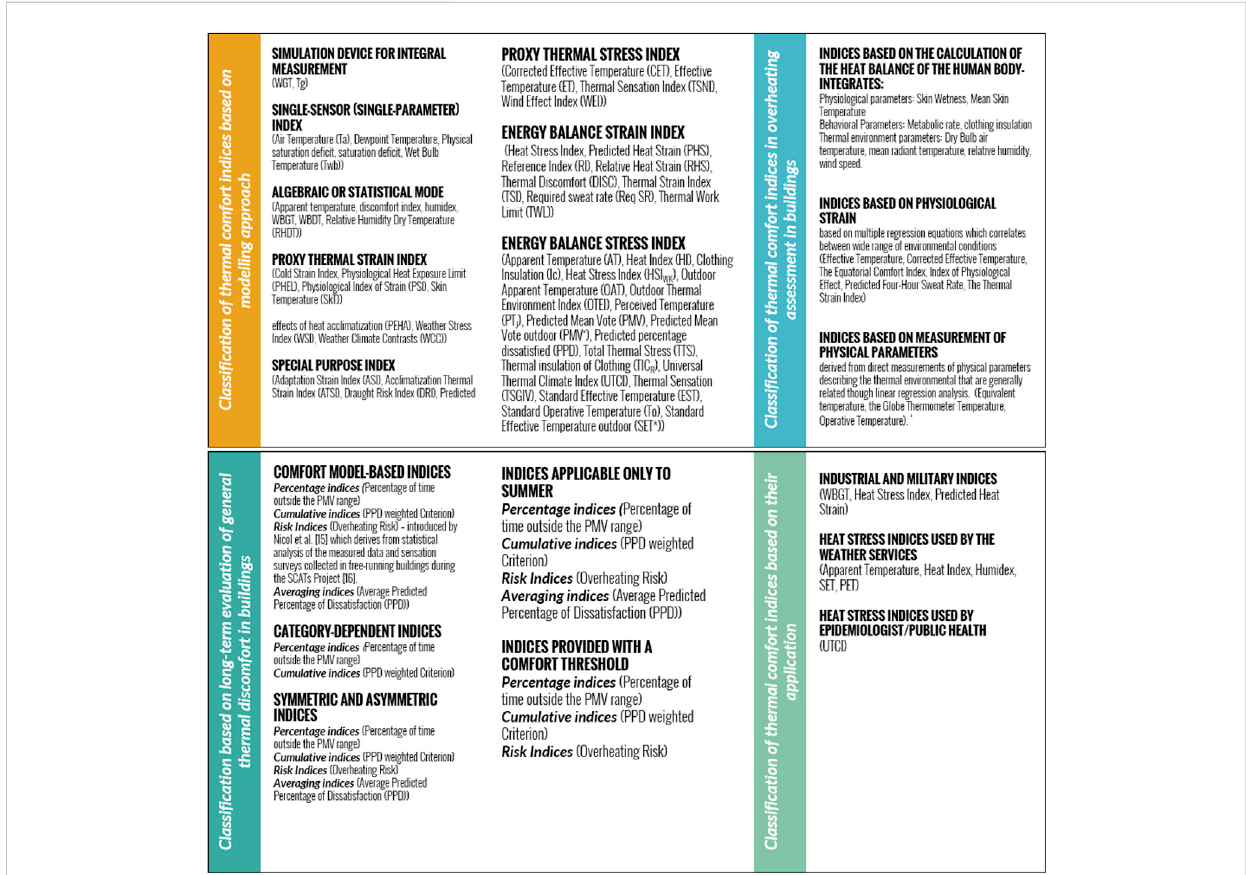
FIGURE 2 DifferentHeatstressindicesandtheirclassi fi cation(developedbytheauthorbasedon(BrakeandBates,2002;Blazejczyketal.,2012;Auliciemsand Szokolay, 2014; Urban and Kyselý, 2014; Holmes et al., 2016; Sen and Nag,